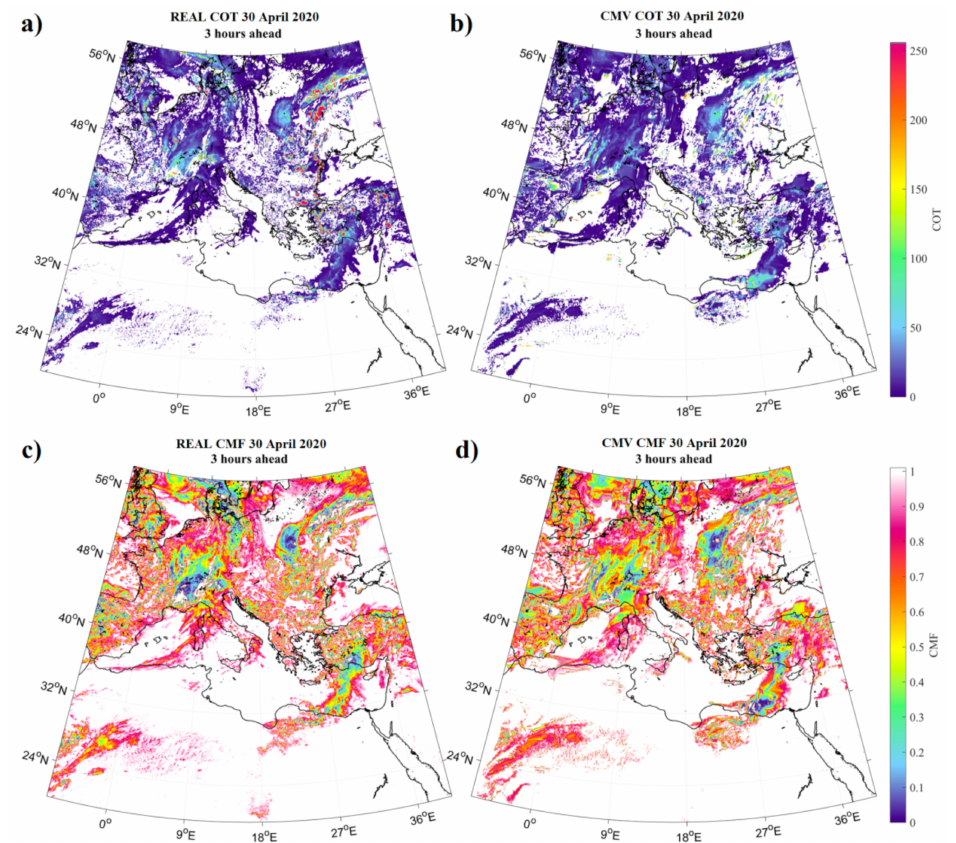
Figure 5. The real ( a ) and the FRB forecasted ( b ) COT map for 30 April 2020 at 12:15 UTC, as well as the corresponding real ( c ) and FRB forecasted ( d ) CMF maps for 3 h-ahead (12 time-step